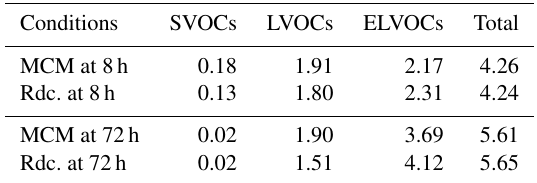
Figure 7. Geographic distributions of the (a) error and (b) average SOA concentration of the testing results in July and August sim- ulated using the Rdc. mechanism. The total number of conditions displayed is 4717 out of the 12159 that were tested. The results of all testing conditions are shown in Appendix B for reference.